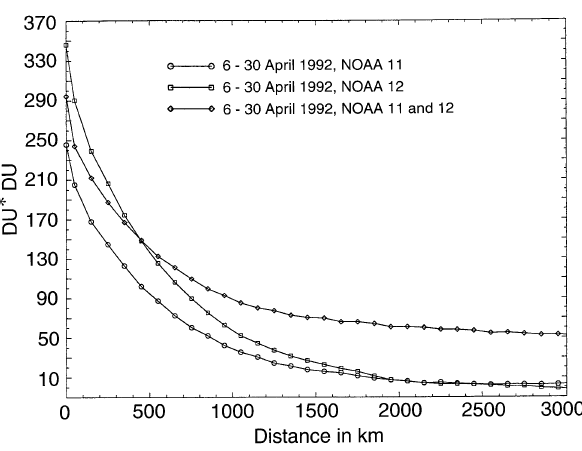
Fig. 3. The error covariance ( (cid:117) (cid:48) ! (cid:117) (cid:34) ) (cid:107) ( (cid:117) (cid:48) ! (cid:117) (cid:34) ) (cid:108) averaged for 6 to 30 April